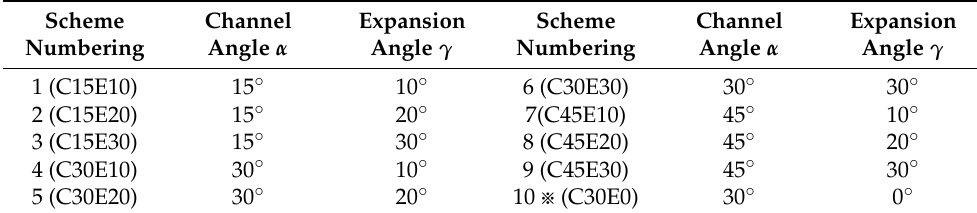
Table 1. Schemes of dual-channel structure.